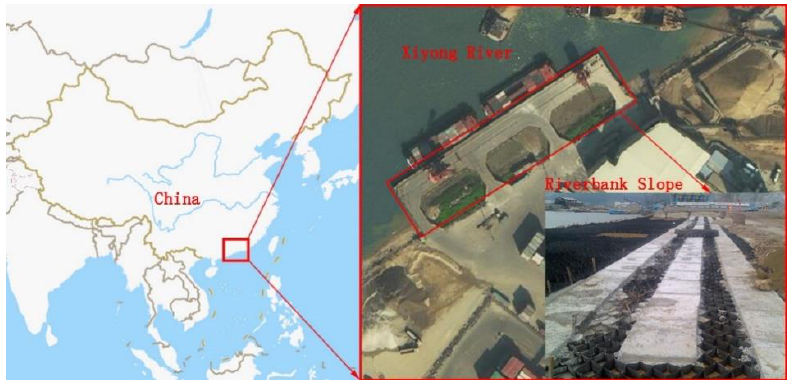
Figure 3. Location of the riverbank slope for the model developed in this study.